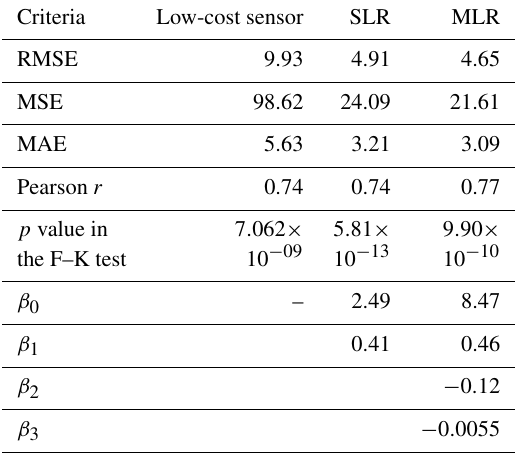
Table 2. Calibration results by SLR and MLR using the test dataset.